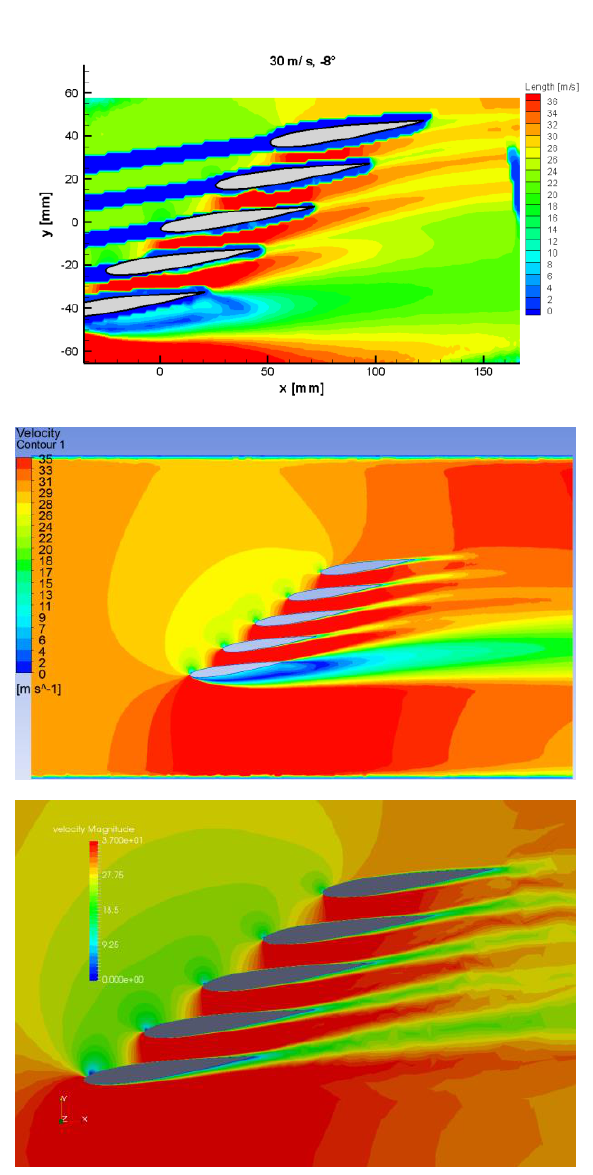
Fig. 3b, c, d. PIV, Fluent and FlowPro comparison, AoA -8°, velocity 30 m/s, distribution of mean flow velocities